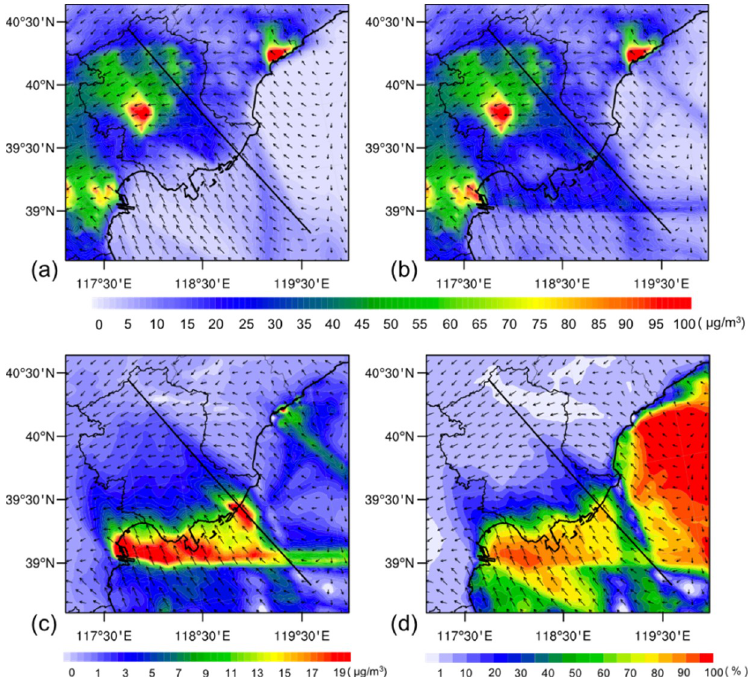
Figure 6. Average NO 2 concentration ( µ g / m 3 ) for the case of no ship emissions ( a ), case of with ship emissions ( b ), average ship contribution to NO 2 in µ g / m 3 (with – without ships) ( c ) and in % ((with – without ships) / with ships)) ( d ) at ground level overlaid by the averaged 10-m wind vectors during the period from 12:00 to 24:00.